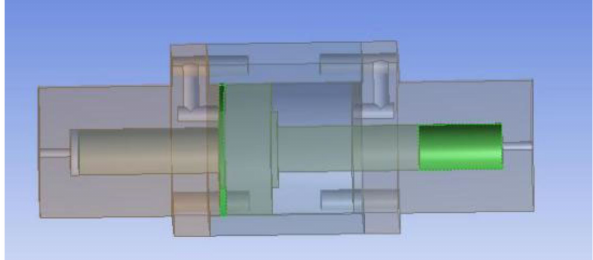
Figure 8. The piston is at the leftmost end.